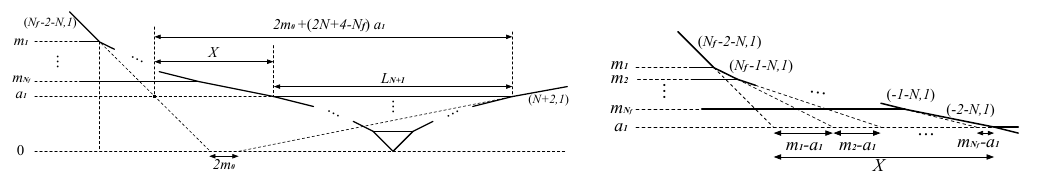
Figure 23 . A face that appears in the 5-brane web diagram for 5d Sp( N ) gauge theory with N f flavors.